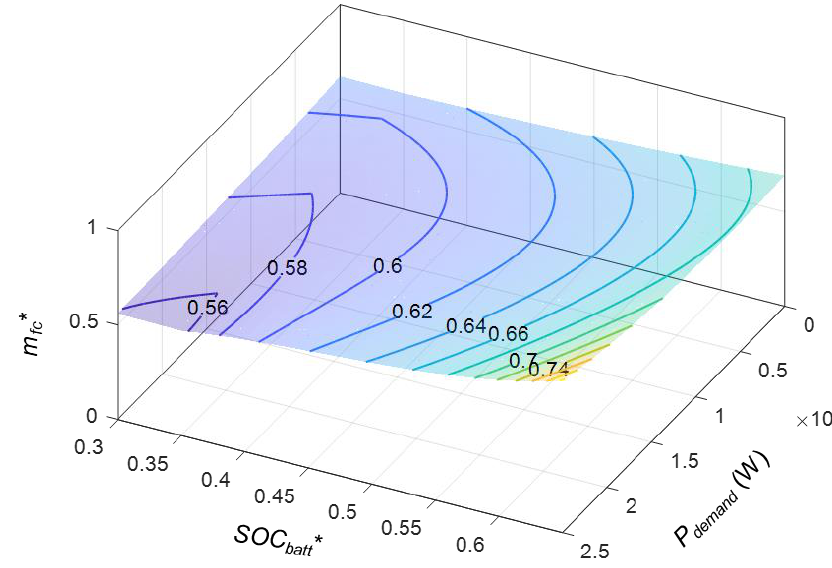
Figure 7. Modulation ratio m fc * with respect to the given P demand and the SOC batt *.